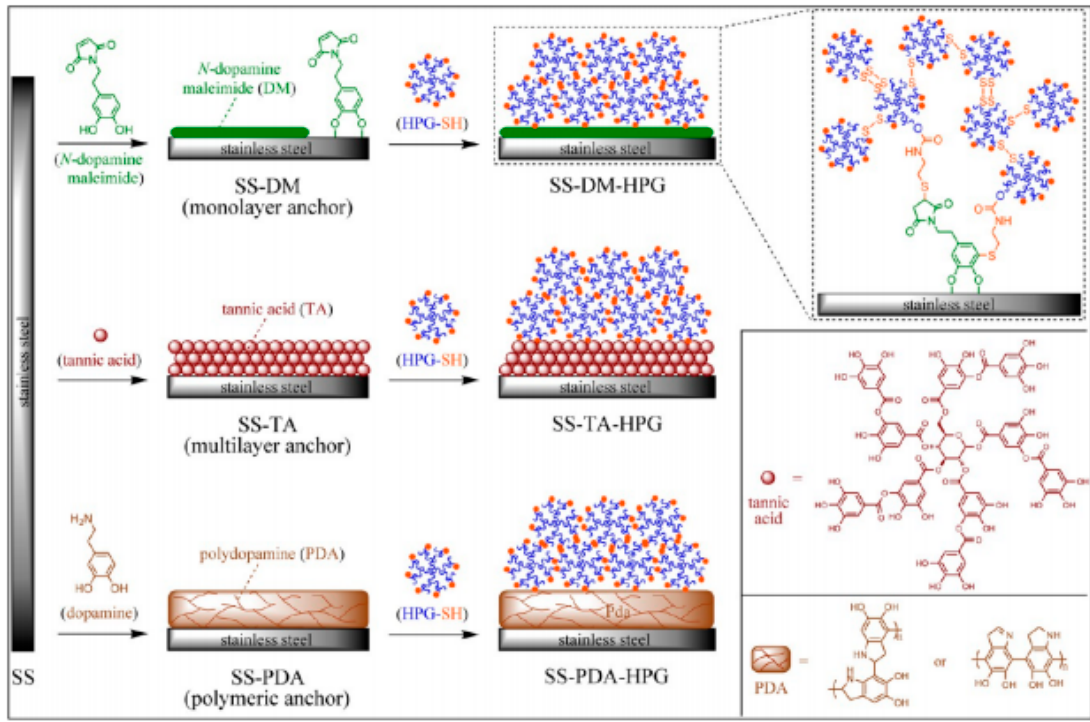
Figure 5. Schematic representation of the HPG-SH structure and the coating approach followed by Teo and Kang and co-workers [101] with covalent attachment of HPG-SH on three mussel-inspired primers on stainless steel (monolayer of N -dopamine maleimide, top ; tannic acid, middle ; polydopamine, bottom ). Reproduced with permission from reference [101]. Copyright (2016) American Chemical